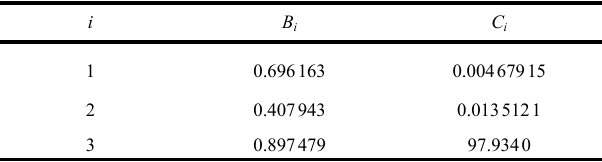
Table 1 Parameters of fused silica for Sellmeier